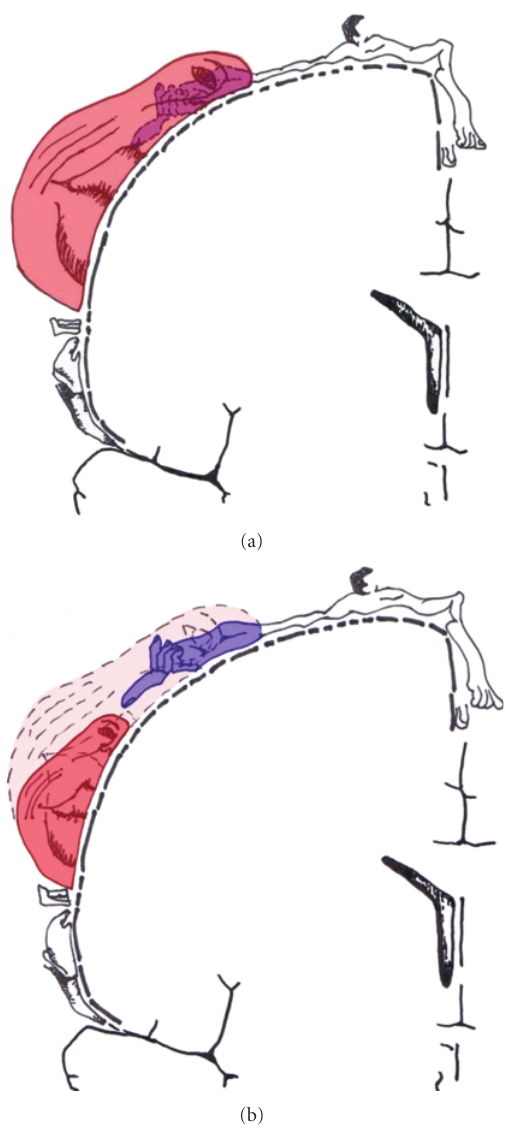
Figure 1: Topographical somatotopic reorganization in the sen- sorimotor cortices following dea ff erentation by a brachial plexus avulsion injury (a) and normalization of the reorganization by application of local anesthesia in the mouth